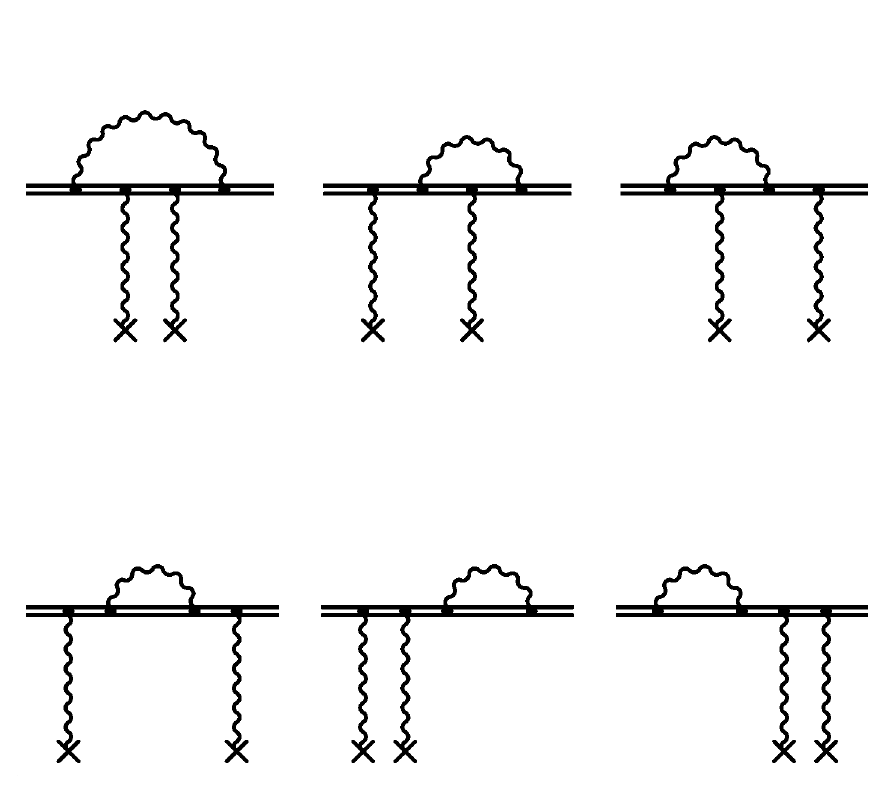
Figure 3: Fourth order Feynman diagrams vertex-vertex (VV), left-vertex (LV), vertex-right (VR), left-right (LR), left-left (LL) and right-right (RR) contributing to self-energy correction quadratic in the external field corresponding to the S